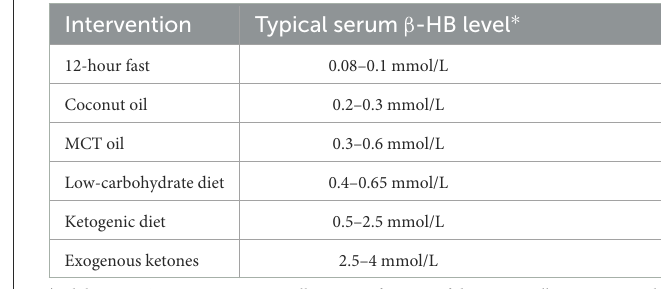
TABLE 4 Relative potency of ketogenic